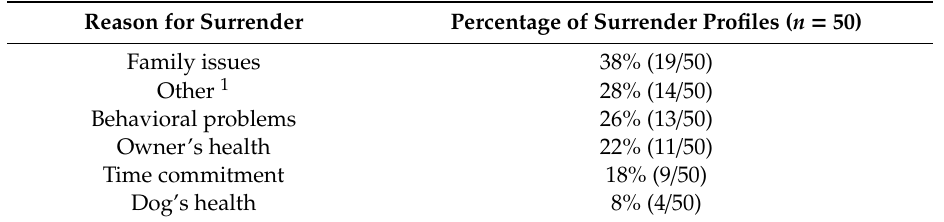
Table 5. Reasons provided by owners for surrendering their dog to the shelter, ranked from highest to lowest. Owners were asked to circle all that apply, so percentages do not add to